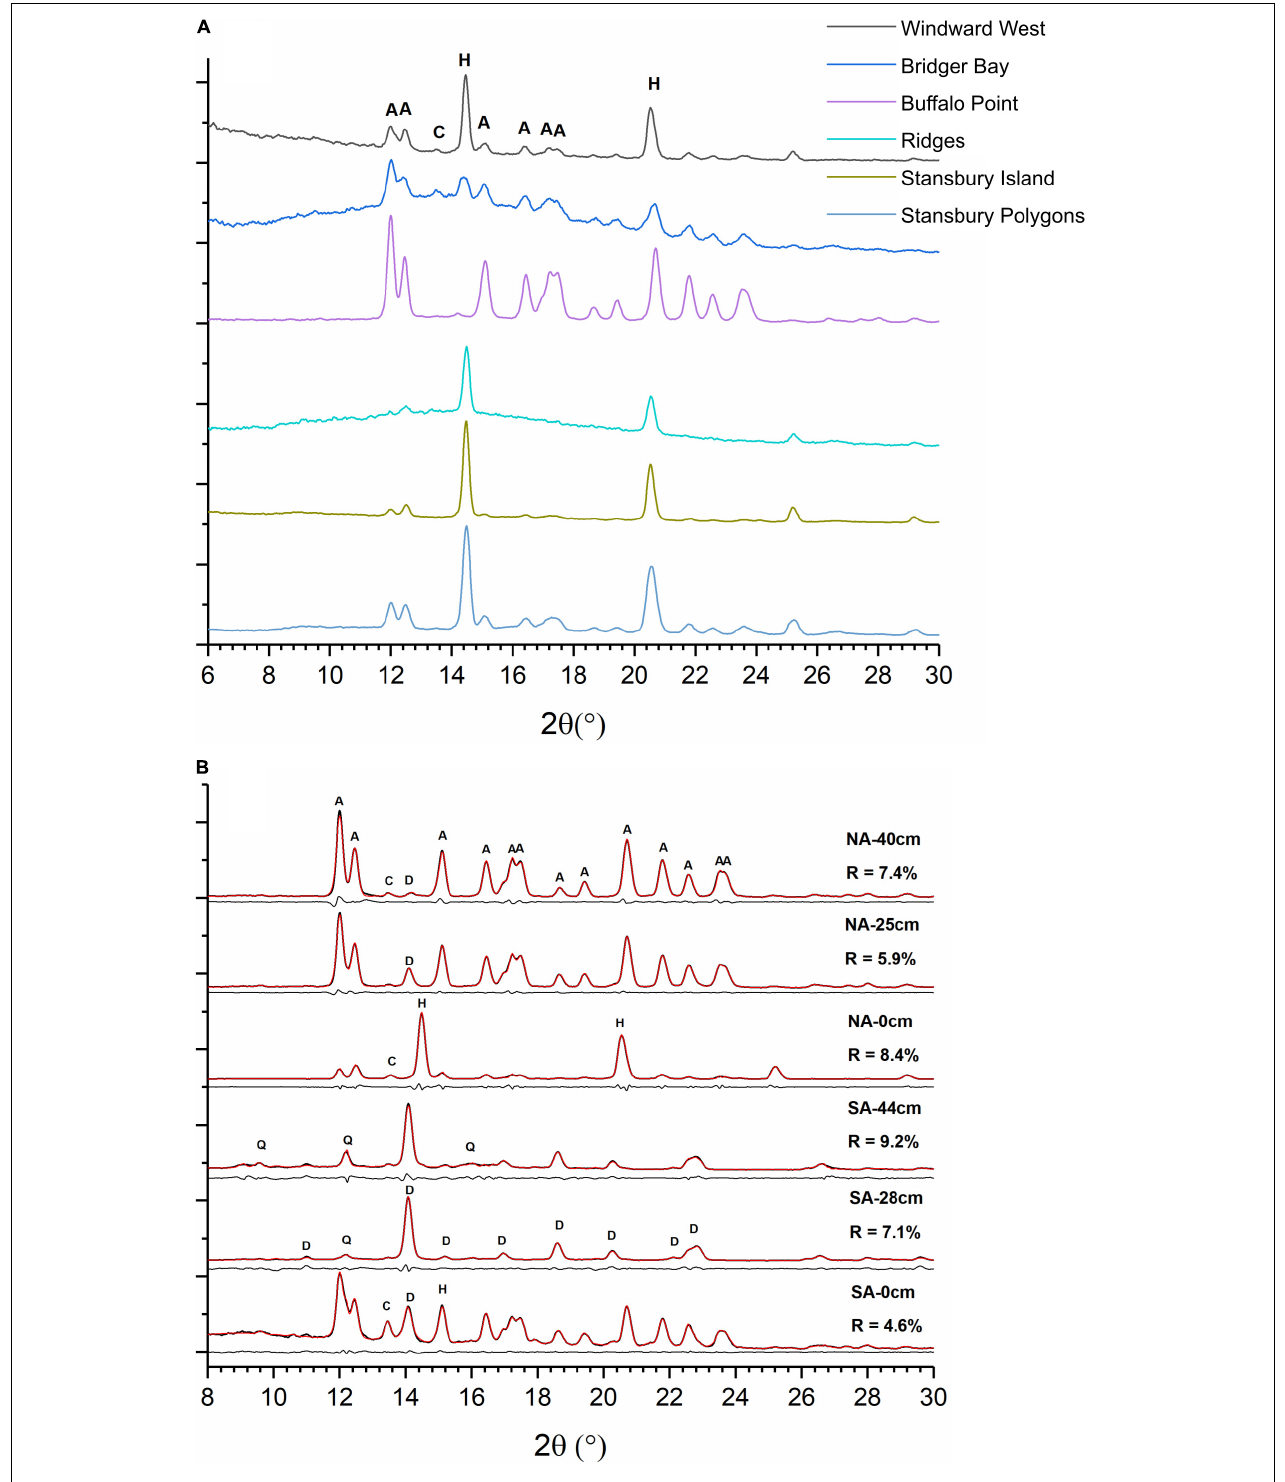
FIGURE 2 | (A) X-ray diffraction (XRD) patterns of microbial mats from the South Arm (SA) of Great Salt Lake (GSL). Mats are dominated by aragonite (A) and halite (H) with trace amount of calcite (C). (B) Representative XRD patterns of sediments from the North Arm (NA) and SA cores at indicated depths below the sediment–water interface. Thin red lines are refined results overlaid on black original data. Thin black lines below each pattern are residues from Rietveld refinement. NA sediments are dominated by aragonite, halite, and calcite, with trace amounts of high magnesian calcite/protodolomite (D). SA sediments are dominated by high magnesian calcite/protodolomite with small amounts of halite, calcite, and quartz (Q).